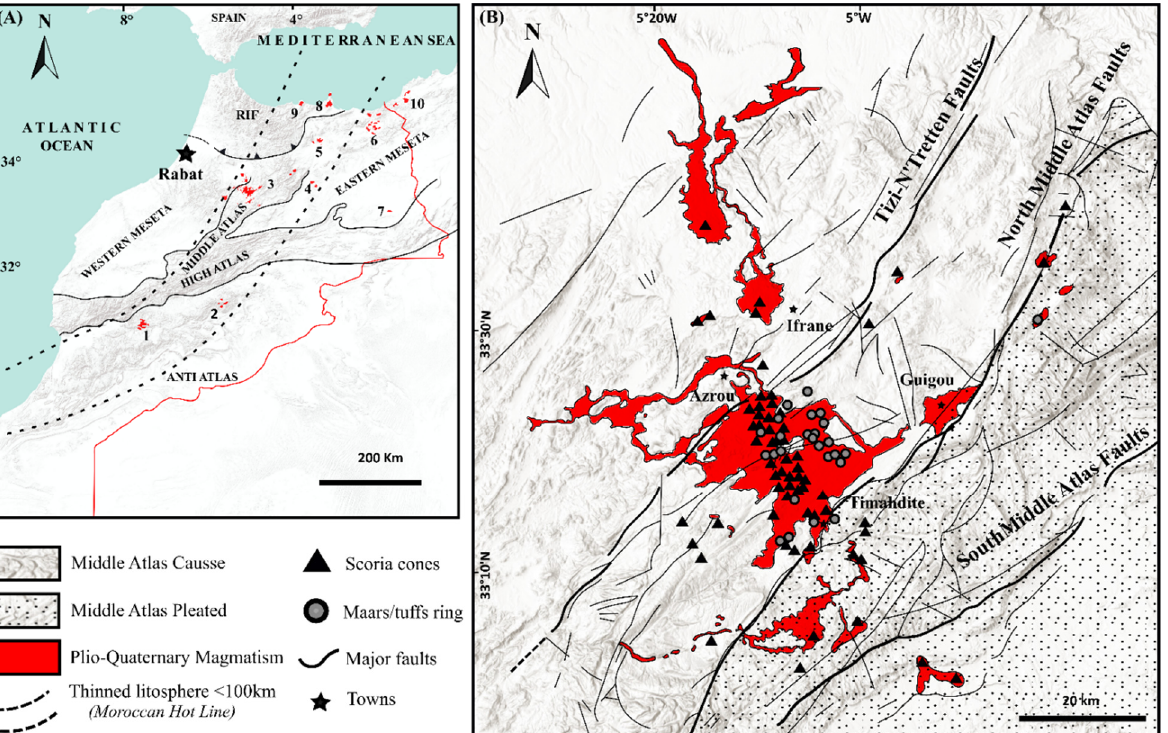
Figure 1. ( A ) Simplified map of Northern Morocco showing the principal structural domains and the thinned lithosphere belt < 100 km with volcanism of (1) Siroua, (2) Saghro, (3) Middle Atlas, central Morocco, (4) Rekkam, (5) Guilliz, (6) Oujda, (7) Tighri, (8) Gourougou, (9) Ras Tarf, (10) and Ouranie (modified from [54,55]); ( B ) Geological map showing the studied volcanoes and the principal geological features of the MAVF (modified from